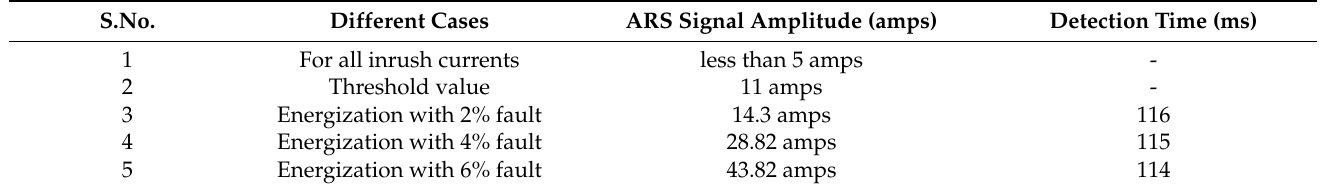
The Table 6 indicates the fault detection time with respect to the severity of the faults along with ARS signal amplitudes for different cases. Table 6. ARS signals and the fault detection time for various